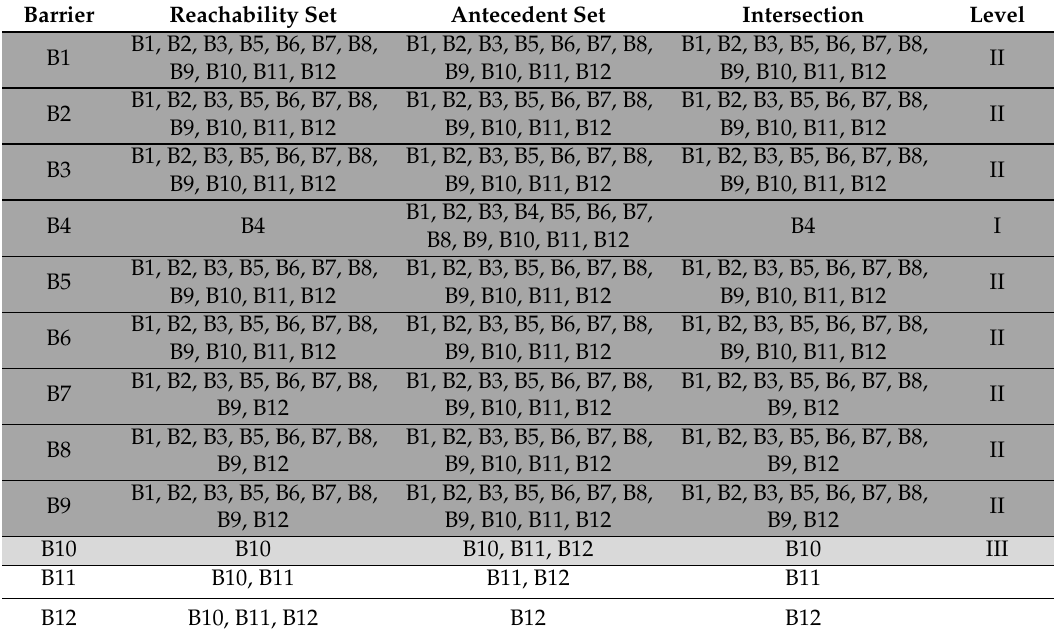
Table 7. Partition matrix (PM) and barrier (B1–B12) levels—3rd iteration of ISM computations. Barrier Reachability Set Antecedent Set